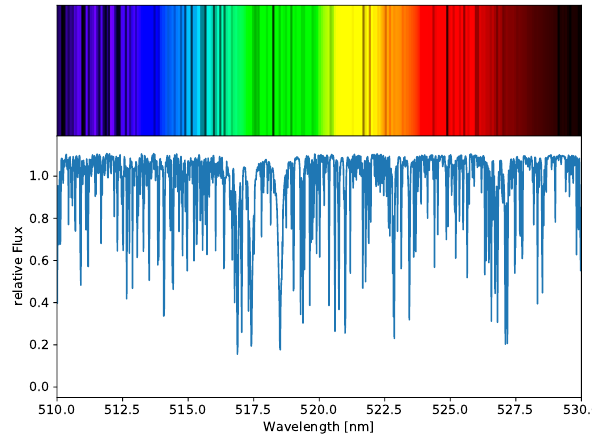
Fig. 19.— Solar spectrum as a curve (bottom) and the recon- structed version of a slit spectrum image (top). Data from the IAG Solar Flux Atlas, Reiners et al.